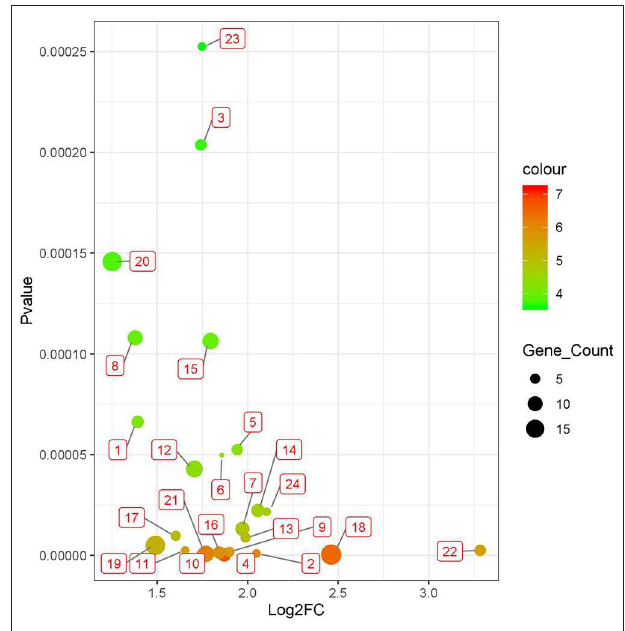
FIGURE 3 | Twenty four significant survival-related gene sets detected in brain lower grade glioma with datasets from the cBioPortal database ( Table 1 ). The corresponding genes of each gene set are shown in Supplementary Tables S1, S4